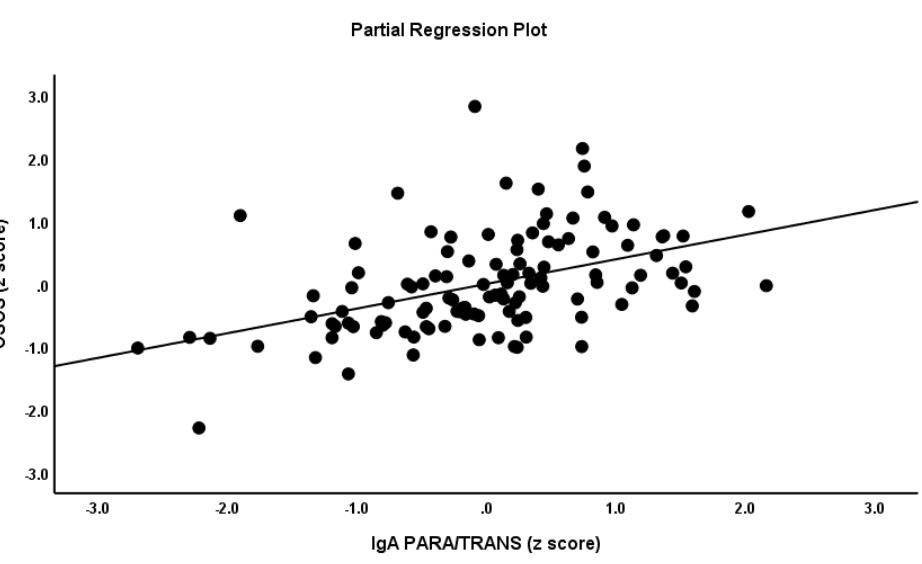
Figure 1. Partial regression plot of the general factor (GF) OSOS (overall severity of schizophrenia) on IgA to paracellular / transcellular